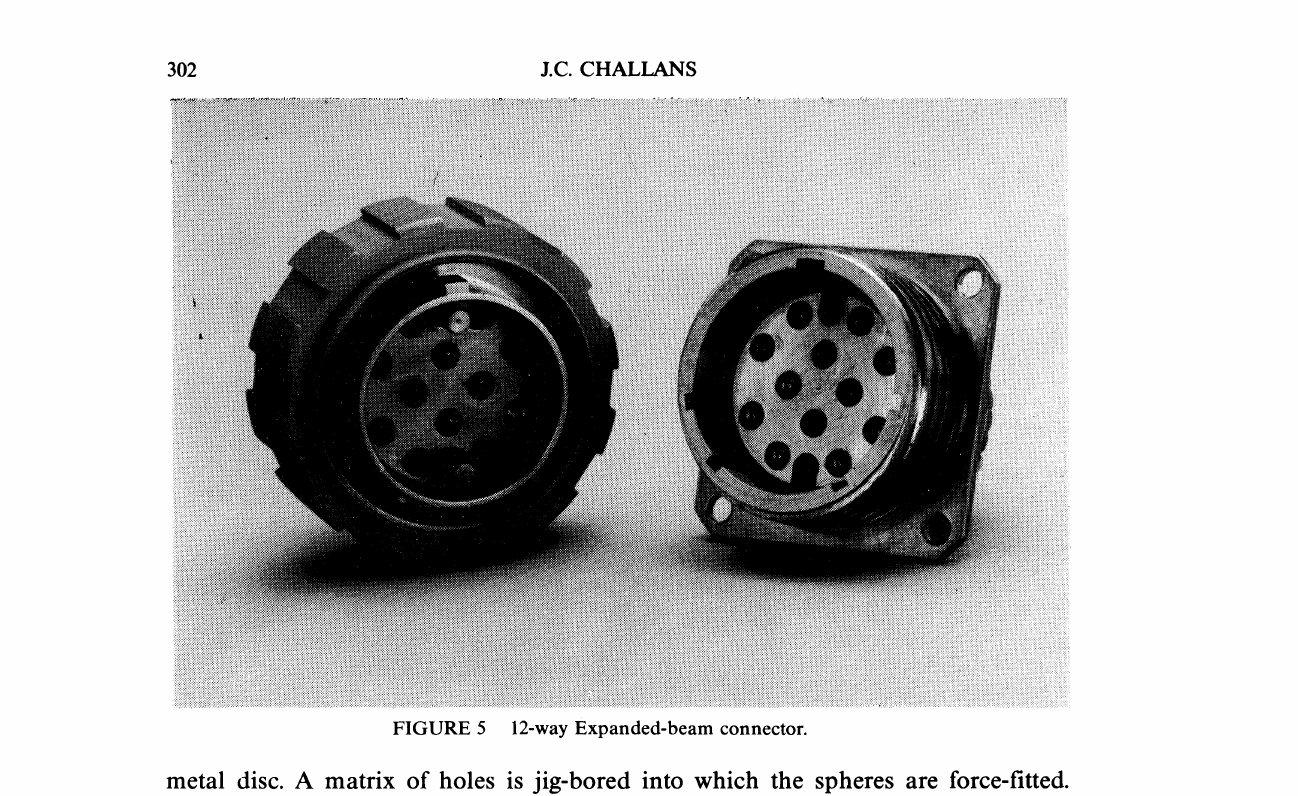
FIGURE 5 12-way Expanded-beam